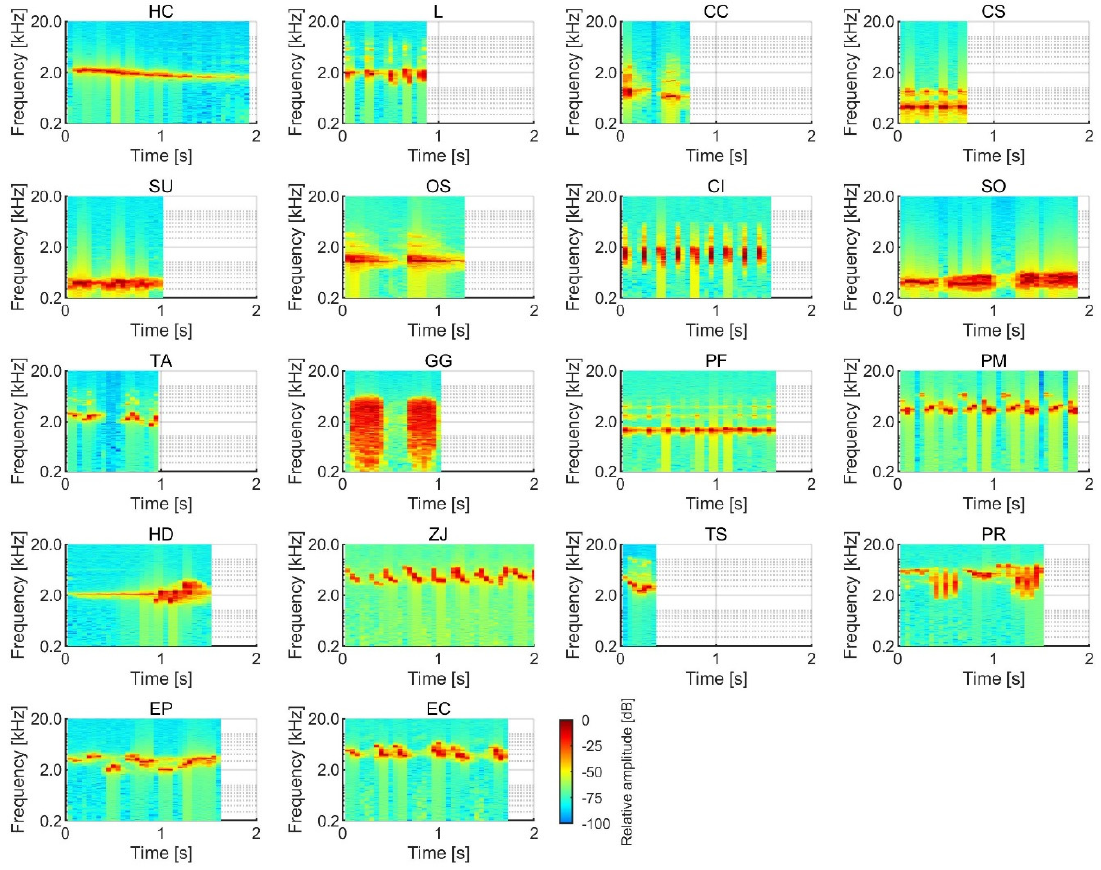
Figure 3. Spectrograms of the 18 birdsongs.